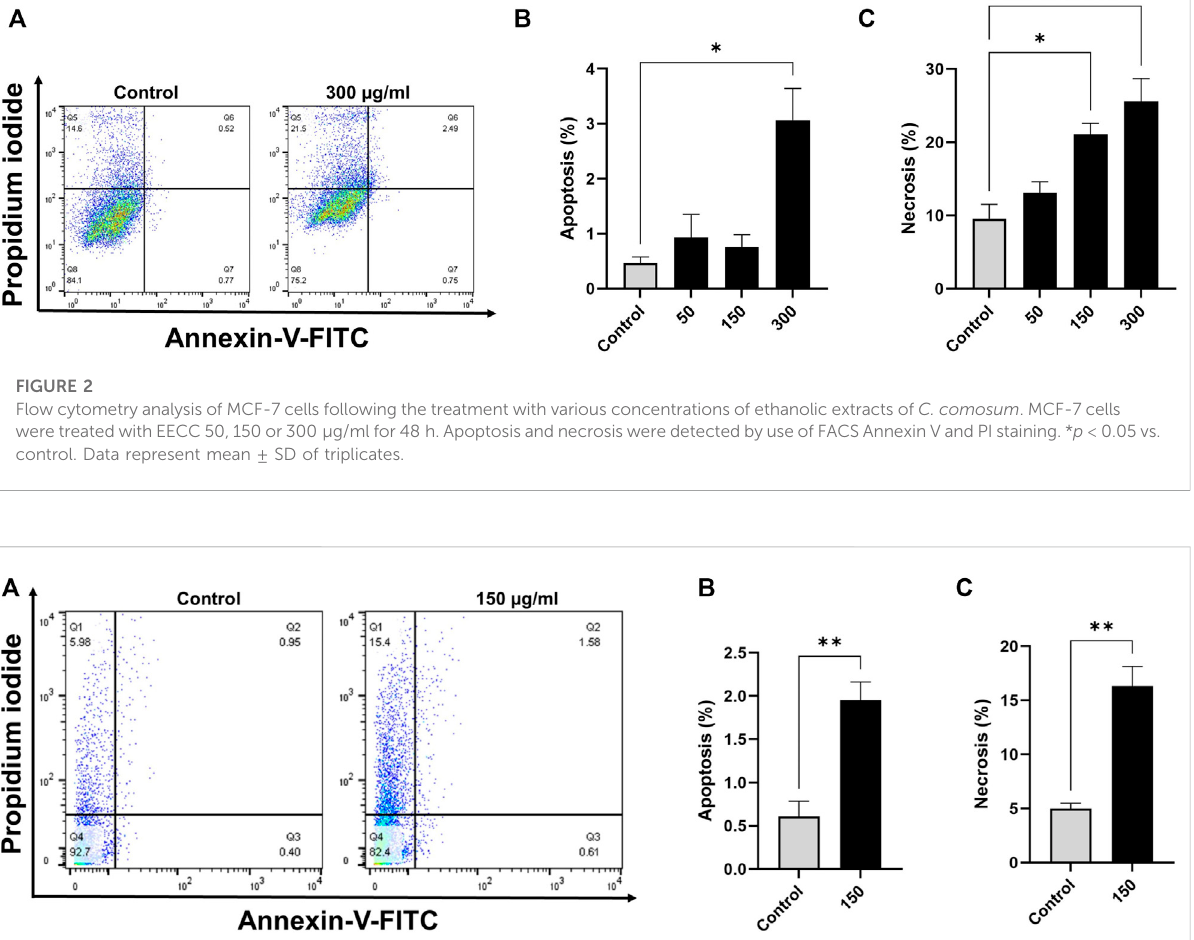
FIGURE 3 Ethanol extract of Colligonum comosum (EECC) induces apoptosis and necrosis in MDA 231 cells. MDA 231 cells were treated with indicated concentrationsofEECCfor48 h.CellswerethenlabeledwithAnnexinVandPIandanalyzedby fl owcytometryasdescribedintheMethodssection. ** p < 0.01 vs. control. Data represent mean ± SD of